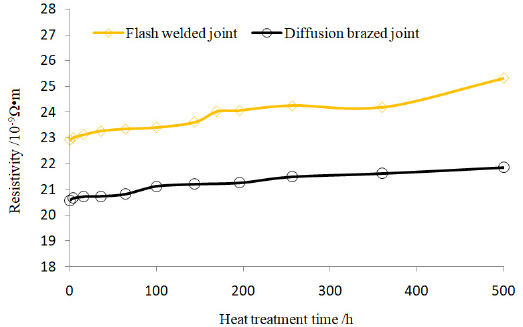
Figure 10. Variation of Cu/Al joint resistivity with heat treatment time at 350°C